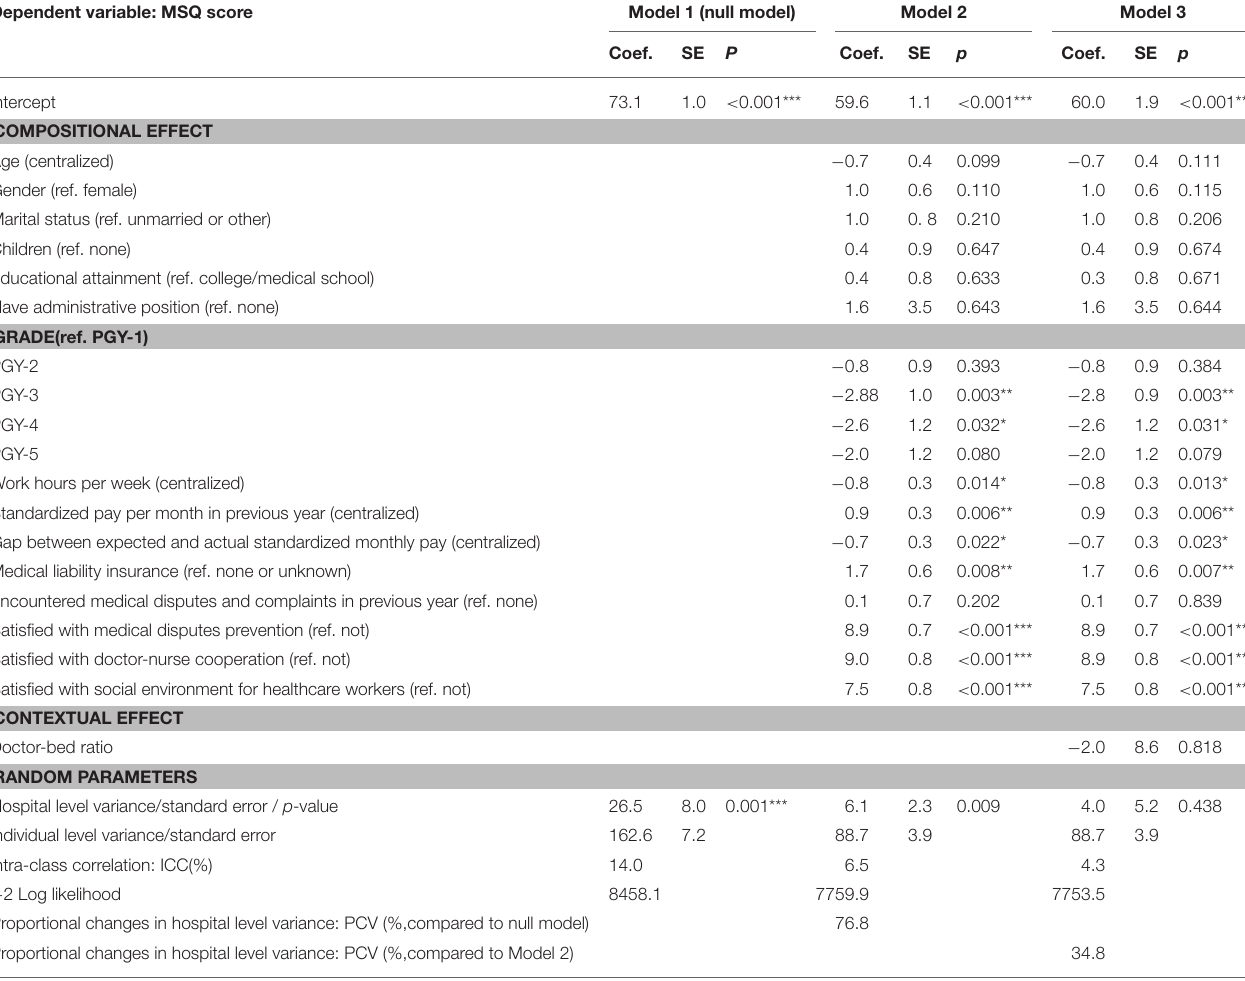
TABLE 3 | The association between individual- and hospital-level characteristics applying multilevel linear regression ( N = 1,060). Dependent variable: MSQ